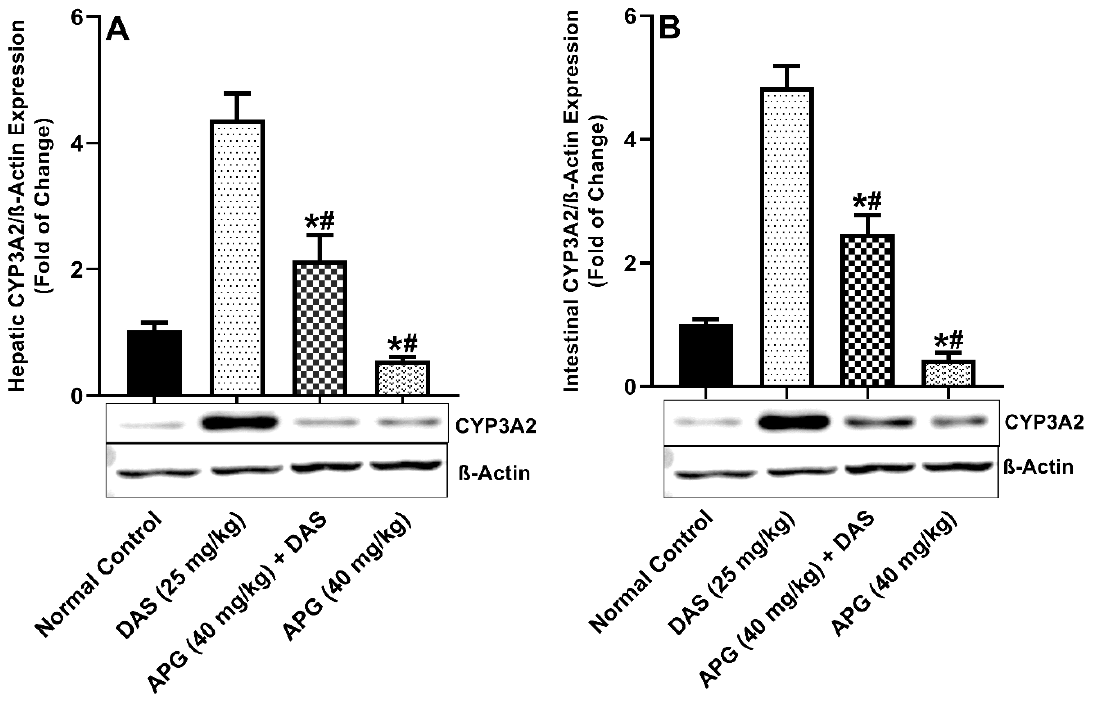
Figure 3. Hepatic ( A ) and intestinal ( B ) CYP3A2 protein expression in rats after DAS administration with or without APG pretreatment. All results are presented as the average ± SD. * p < 0.05 (Normal control); # p < 0.05